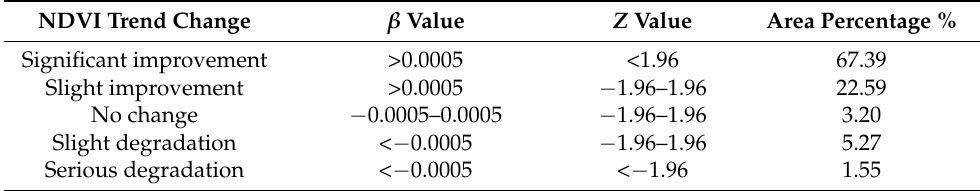
Table 2. Trends of vegetation NDVI in the middle reaches of the Yangtze River (MRYR).